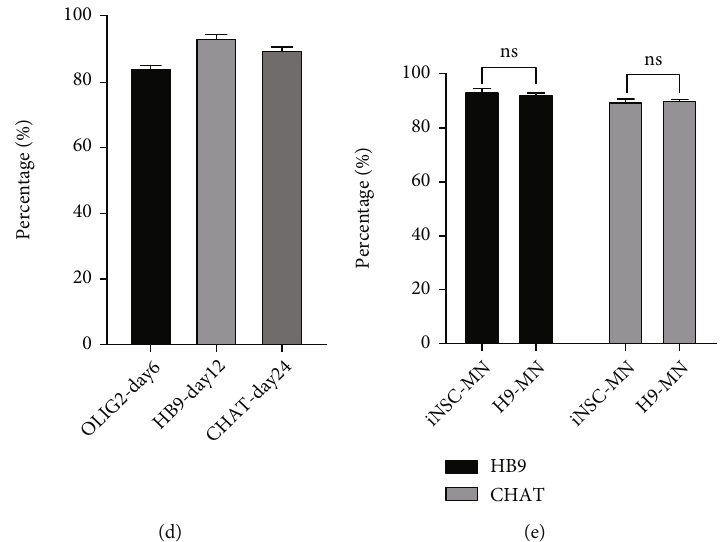
Figure 4: Di ff erentiation of iNSCs into motor neurons in vitro. (a) Flow chart of the di ff erentiation of iNSCs into motor neurons in vitro. (b) Representative pictures of cells at di ff erent di ff erentiation time points. (c) Immuno fl uorescence for OLIG2, HB9, and CHAT on iNSC- GFP-di ff erentiated and embryonic stem cell line H9-di ff erentiated cells at di ff erent time points, respectively. Scale bars, 50 μ m. (d) Quanti fi cation of di ff erentiated iNSCs positive for OLIG2, HB9, and CHAT at di ff erent di ff erentiation time points. (e) Comparison of the e ffi ciencies of motor neuron di ff erentiation from iNSC-GFP versus ESCs (H9